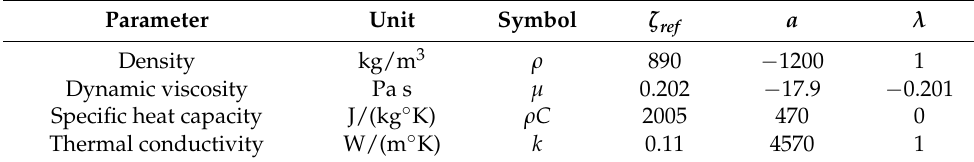
Table 1. Parameters and their dependency constants for SAE90 oil with T ref = 40 ◦ C [1]. Parameter